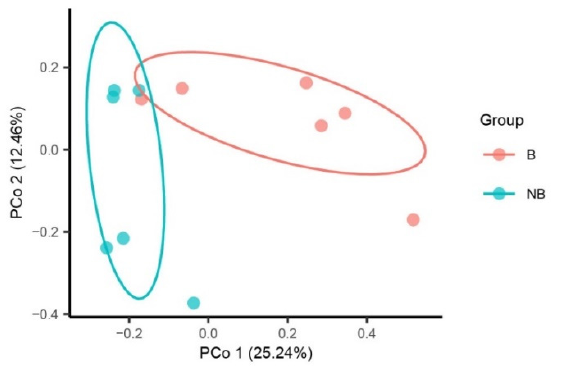
Figure 1. Beta diversity of the gut microbiota in the wild ground squirrel. Principal coordinate analysis (PCoA) plot of the gut microbiota structure using the Bray-Curtis distance metric. B, breeding season; NB, non-breeding season.